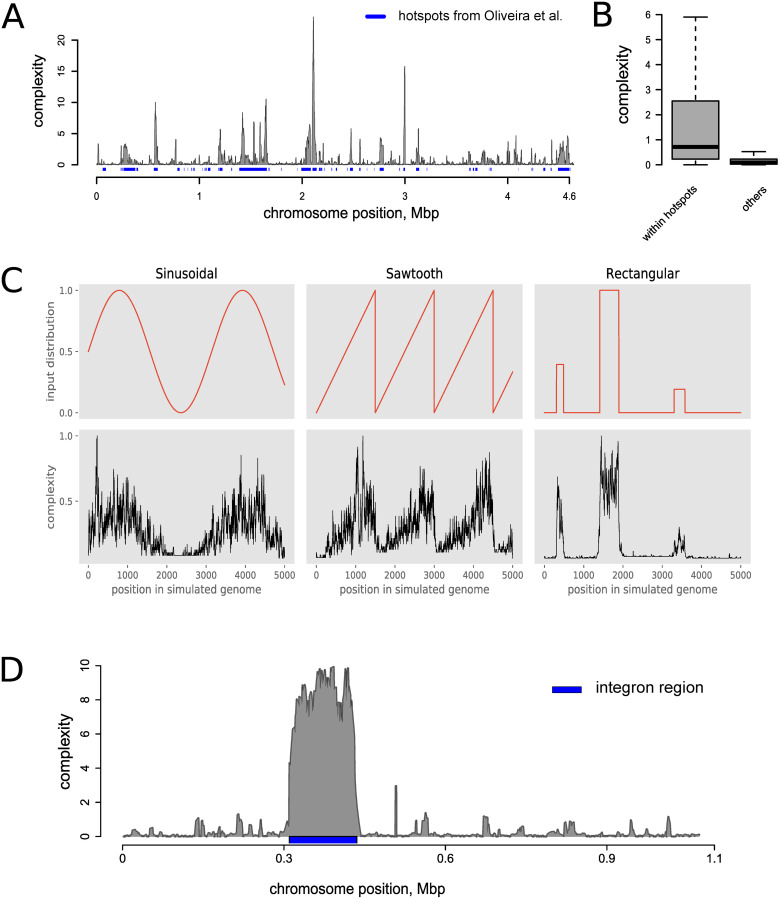
Complexity values can be used as genome variability measures.A) Comparisons of complexity profiles for E. coli K12, with hotspots identified in [35] (blue rectangles underneath complexity profiles). B) Comparisons of complexity values among genes located inside and outside of the hotspots identified in [35]. C) Comparisons between the initial variability profiles and the complexity profiles that were calculated based on the artificial genomes, after 3,000 evolution simulation steps. D) Complexity profiles for Vibrio cholerae N16961, chromosome II, with noticeably high levels of complexity at the integron regions.